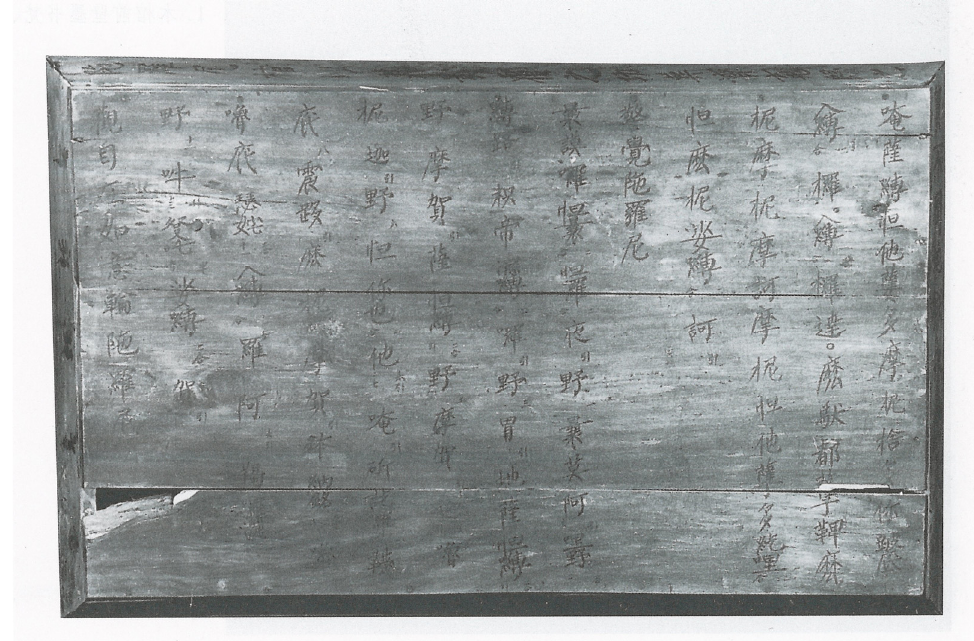
Figure 6. Ink inscriptions of Buddhist incantations in Chinese transliteration on the top of the lid. Liao dynasty, dated 1093. Excavated from Zhang Wenzao’s Tomb in Xiabali, Xuanhua, Hebei Province of China. After (Hebei sheng wenwu yanjiusuo 2001, vol. 2, Figure 45–2). Composed of a lid in truncated pyramidal shape and rectangular body, the Xuanhua coffins differ markedly from those favored since the Northern and Southern Dynasties.